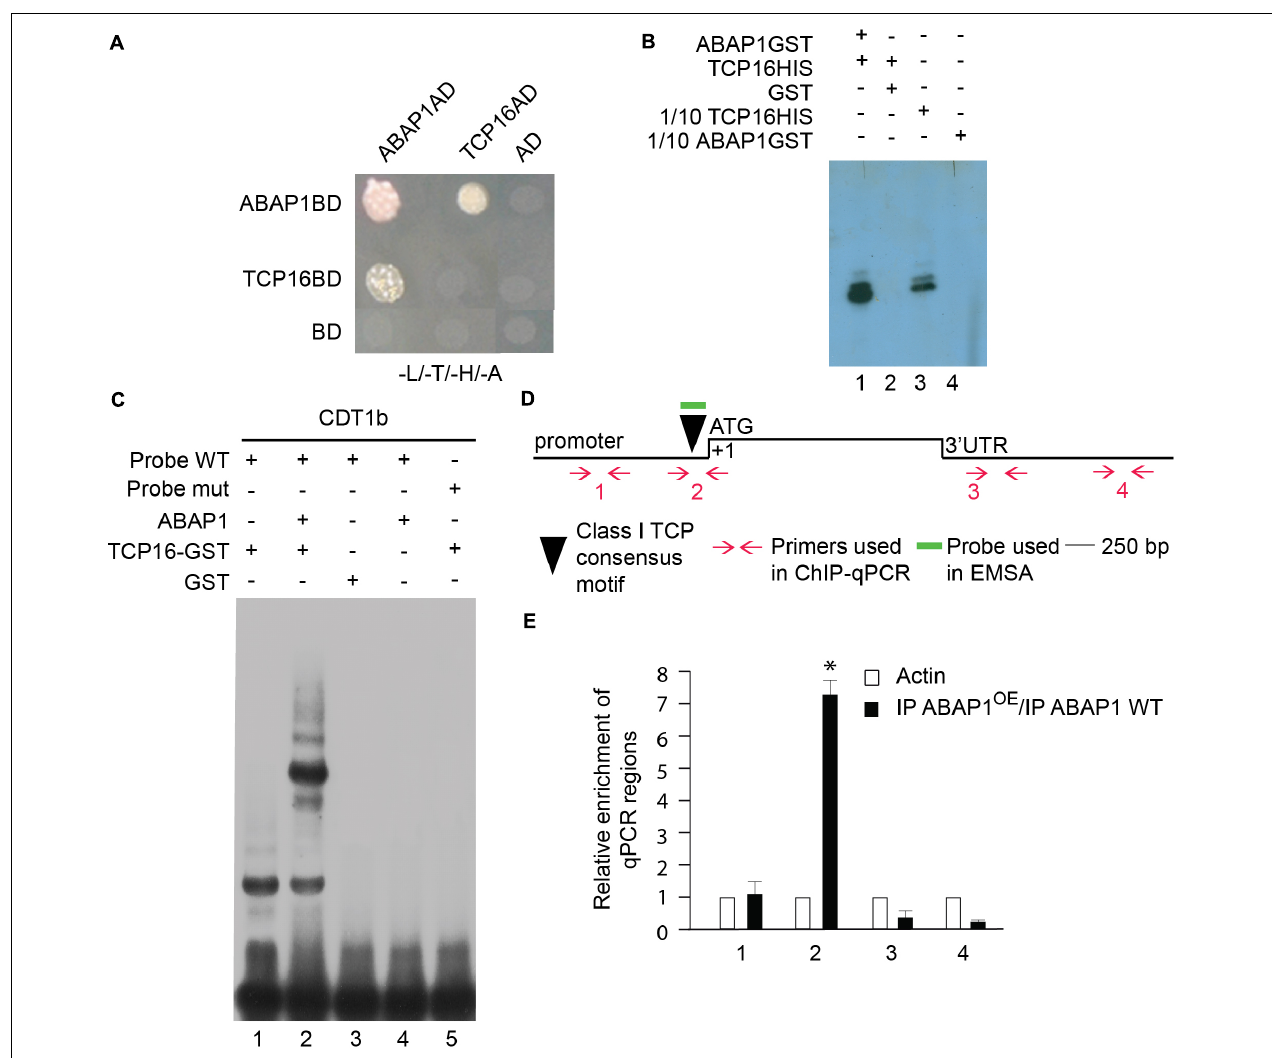
FIGURE 4 | Characterization of the interaction between ABAP1 and TCP16 and their role in transcription. (A) Yeast two hybrid interaction assays between ABAP1 and cloned in both AD and BD vectors. Negative controls used DAD and DBD empty vectors. The panel shows conjugated yeasts growing in SD medium lacking leucine, tryptophan, histidine and adenine, for selection of strong protein interactions. (B) GST-pull down assay between ABAP1–GST and TCP16-HIS produced in E. coli . Western blot analysis used anti-HIS antibody. Lane 1, TCP16-HIS with ABAP1-GST; lane 2, TCP16-HIS with GST alone; lanes 3 and 4, 1/10 inputs of ABAP1-GST and TCP16-HIS, respectively. (C) EMSA of ABAP1, TCP16 and the complex TCP16–ABAP1 with wild-type (WT) and mutated (mut) radiolabeled probes of CDT1b promoter regions harboring TCP recognition box. Lane 1, TCP16 binds to CDT1b WT probe; lane 2, addition of ABAP1 causes a supershift in the TCP16 binding to CDT1b WT probe; GST alone (lane 3) or ABAP1 alone (lane 4) do not bind to CDT1b WT probe; lane 5, TCP16 does not bind to CDT1b mutated probe. (D,E) Chromatin immunoprecipitation of wild-type Col (WT) and ABAP1 OE flower buds with anti-ABAP1. (D) Schematic representation of the amplified regions of CDT1b . Black triangle indicates the class I TCP motif, located at position –130 to –136 bp. Red arrows and numbers indicate primers used for ChIP-qPCR assays, and short green line indicates DNA probe used for EMSA. The translational start site (ATG) is shown at position +1. (E) Chromatin immunoprecipitated with anti-ABAP1 antibody was analyzed by qPCR using gene-specific primer sets, numbered as indicated in (D) . The graph shows the fold enrichment of qPCR amplified regions at the promoter ( 1, 2 ), and 3’UTR ( 3,4 ) of CDT1b . The fold enrichment of each amplified region was calculated as a ratio between IP ABAP1 OE and IP WT of values normalized with values of the ACTIN 2 promoter. Error bars represent the SD of three biological replicates. Asterisk ( ∗ ) indicates significant difference from the enrichment according to Student’s t test ( p -value < 0.05). IP, immunoprecipitated with anti-ABAP1